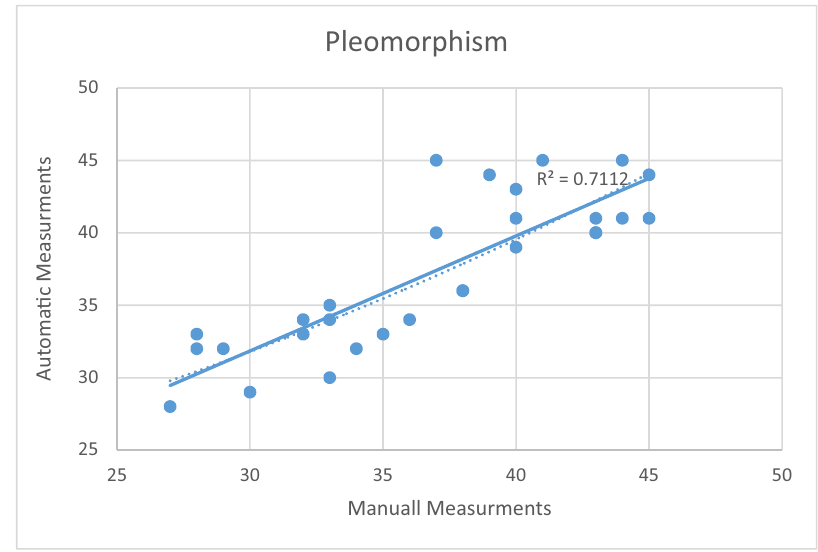
Figure 20: Correlation for the pleomorphism feature for the segmented images.